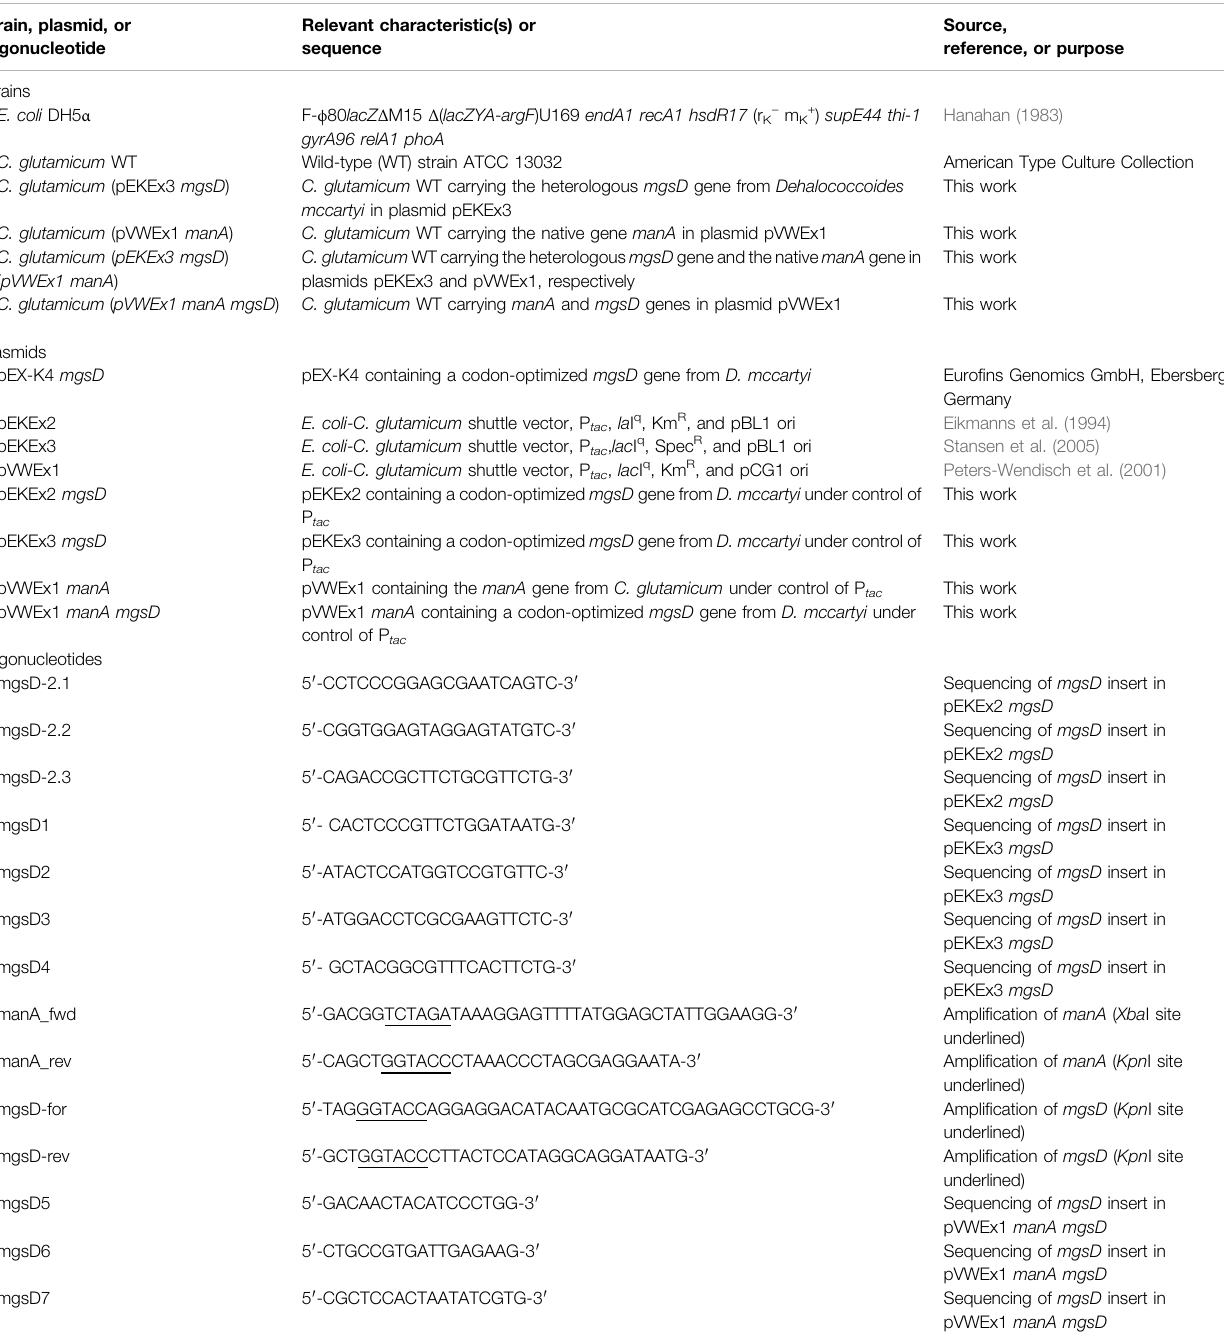
TABLE 1 | Strains, plasmids, and oligonucleotides used in this study. Strain, plasmid, or oligonucleotide